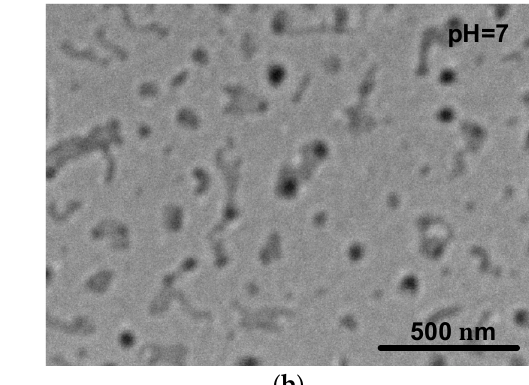
Figure 3. Titration curves ( a ); Effects of pH on D h ( b ) and zeta potential ( c ) of the micelles formed by Ad-P1 and AdP-2.